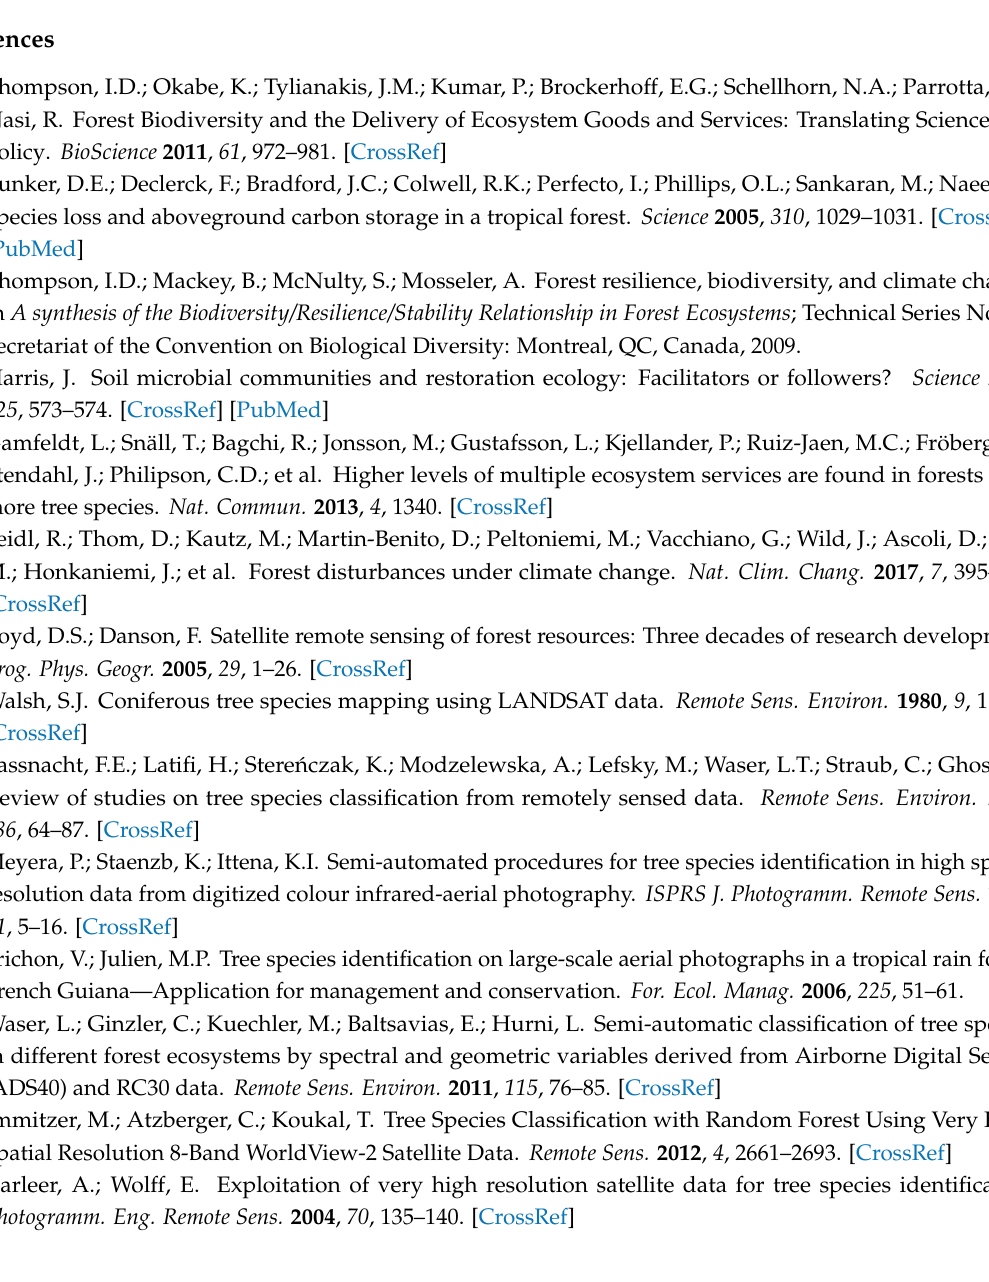
Figure A4. Ranking-based feature selection of image dates for single-year